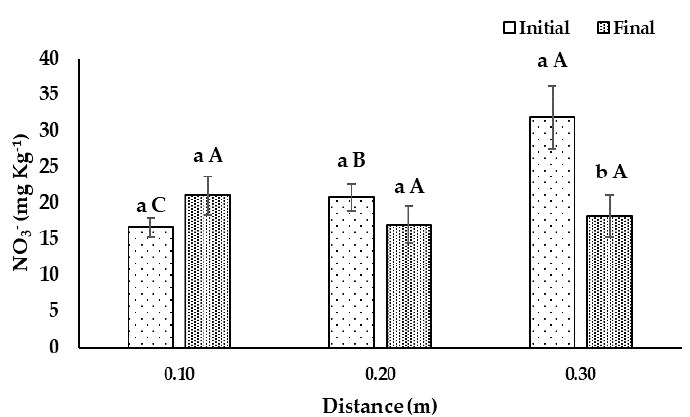
Figure 3. Interaction between distance from the emitter (0.10, 0.20 and 0.30 m) and time of sampling (T. sampling) (initial and final) for soil NO 3- -N concentration (mg kg − 1 ). Lowercase letters are used for the comparison between the time of sampling in each distance from the emitter and uppercase letters are used for the comparison between each time of sampling and distance from the emitter.